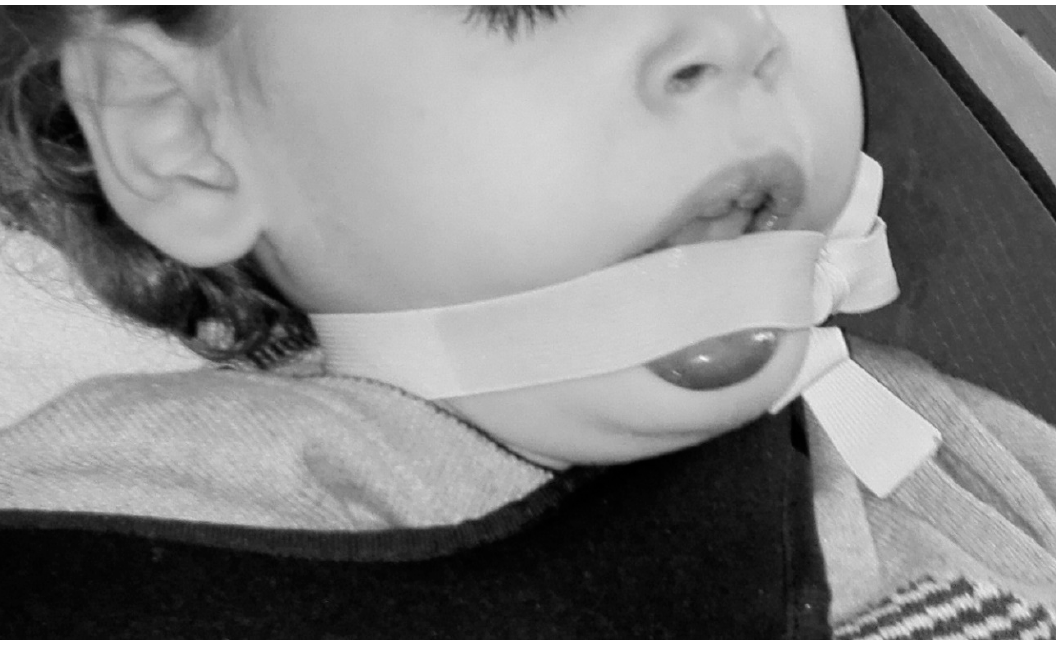
Figure 3. Child with extraoral elastic.